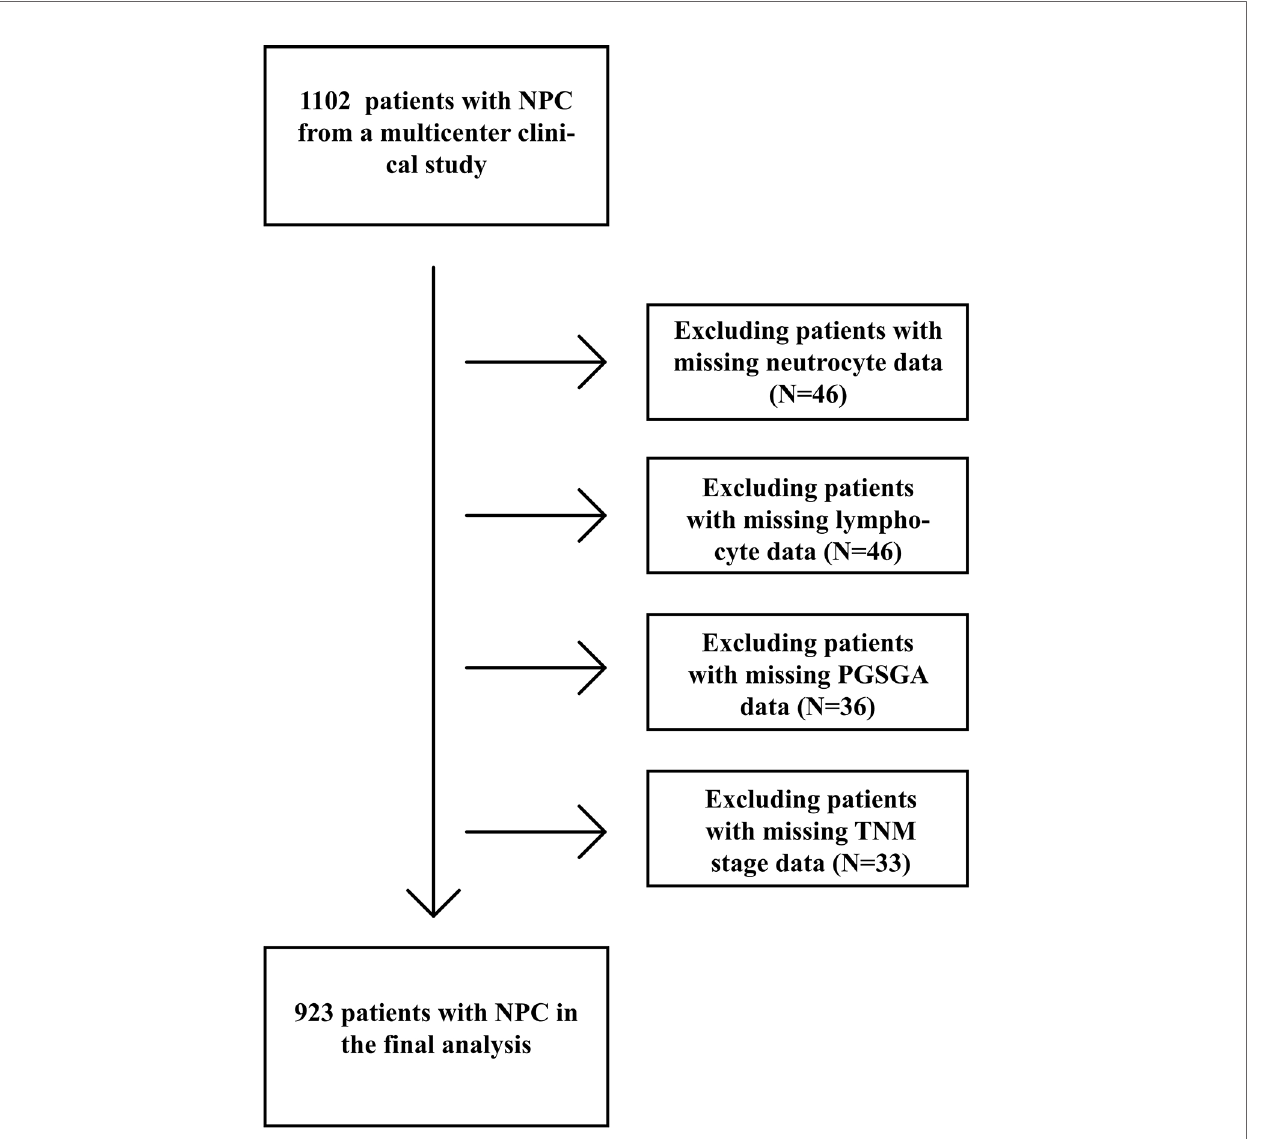
FIGURE 1 | Flowchart of the study